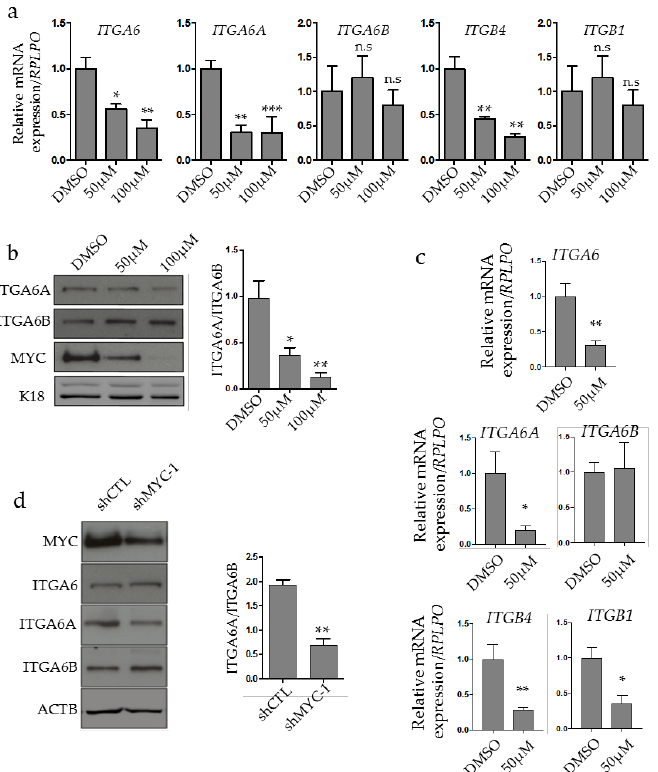
Figure 2. MYC regulates ITGA6 expression and splicing. ( a ) Quantitative RT-PCR analysis of ITGA6, ITGA6A, ITGA6B, ITGB4 and ITGB1 integrin subunits in T84 CRC cells treated with the